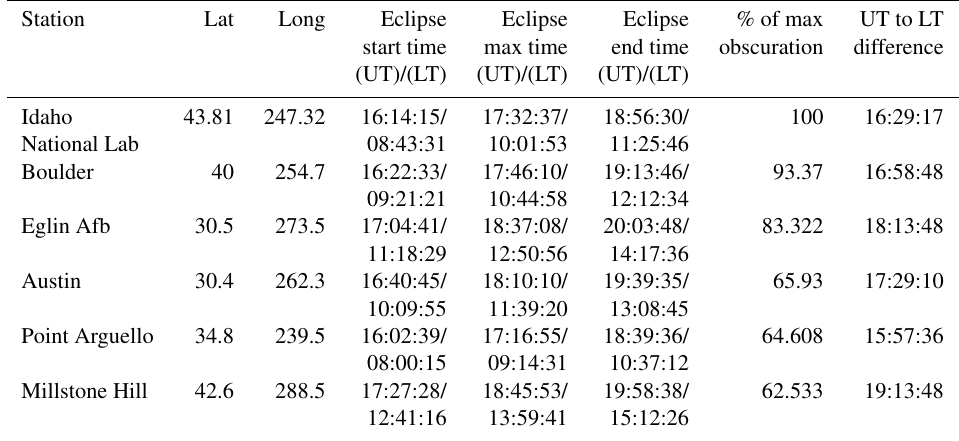
Figure 1. The orthographic map showing the coverage area and circumstances of the solar eclipse, and the observatory stations of the total solar eclipse event of 21 August 2017 . The thick blue line region of represents the path of the maximum magnitude of the eclipse and the pale blue lines mark the region of where the partial eclipse is experienced, with the magnitude of partiality. Table 1. List of ionosonde stations, geographic coordinates, eclipse progression times (universal time/local time) and percentages of maxi- mum